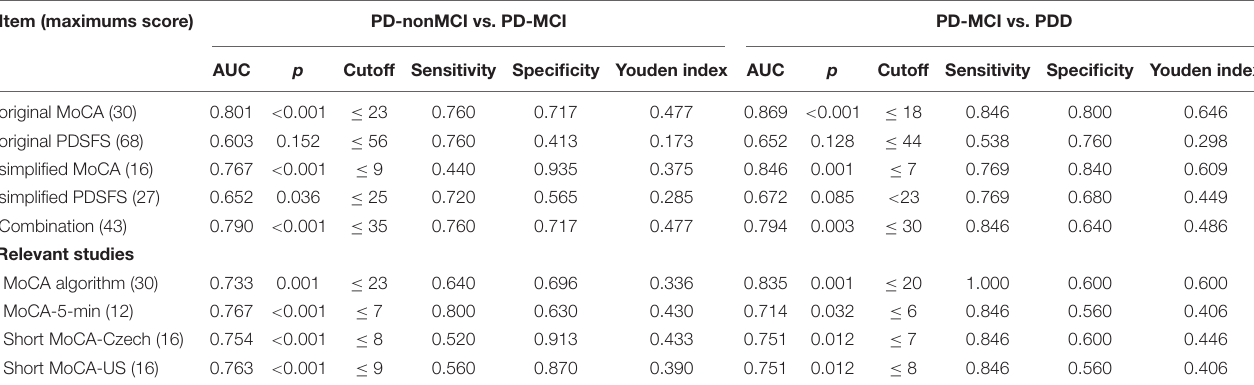
TABLE 9 | The psychometric properties of the MoCA and PDSFS to detect PD-MCI and PDD in this study and relevant studies. Item (maximums